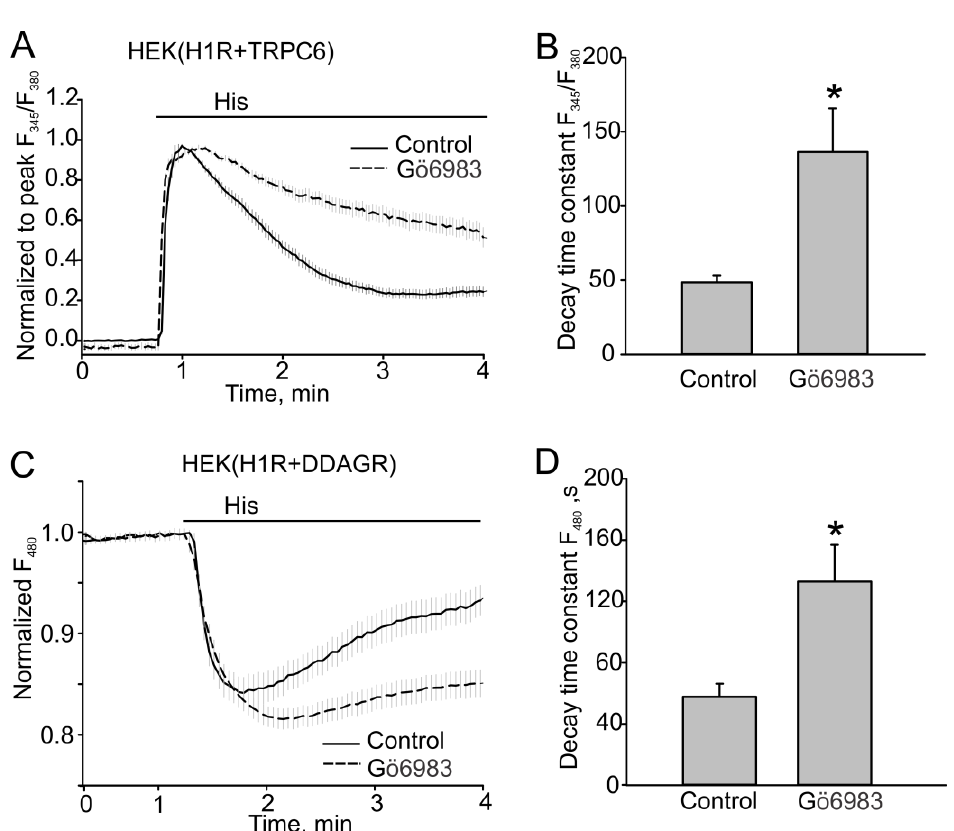
Figure 2. PKC inhibitor Gö6983 slowed the decay of Ca 2+ and DAG signals in the HEK model. ( A , B ) Histamine-induced Ca 2+ transients in HEK cells expressing H1R + TRPC6 in the absence or presence of PKC inhibitor Gö6983 (500 nM). Fura-2 fluorescence ratios (F /F ) are shown. ( A ) Traces of averaged Ca 2+ transients in the control group 345 380 and cells treated with Gö6983 (control, n = 41 vs. Gö6983, n = 39). The ratio data were normalized to the peak amplitude following the baseline fluorescence ratio at time zero was subtracted. ( B ) Summary data comparing the decay time constants for the Ca 2+ transients shown in ( A ). ( C , D ) DAG transients assessed with the downwards DAG+R-GECO sensor excited at 480 nm. The fluorescence was normalized to the baseline fluorescence. The bold and broken lines represent the averaged traces, and the vertical gray lines are the SEM values. Data in ( B , D ) are presented as mean ± S.E. Asterisk = p <